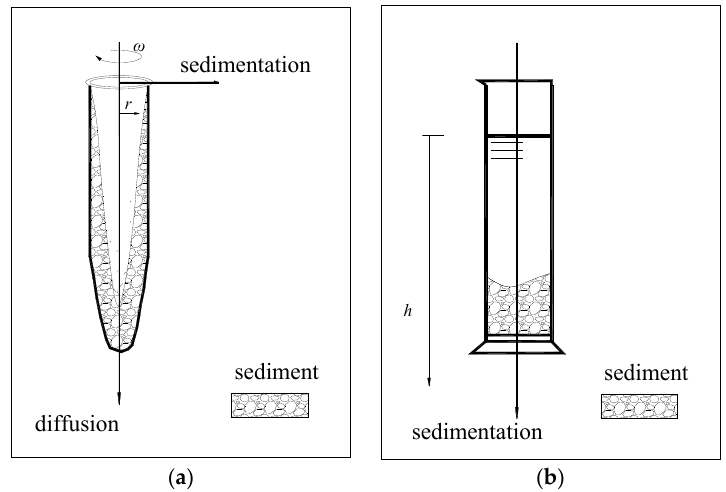
Figure 1. ( a )Thenon-idealsedimentationmodeland( b Figure 1. ( a ) The non-ideal sedimentation model and ( b ) the modified constant-gravity sedimentation model.